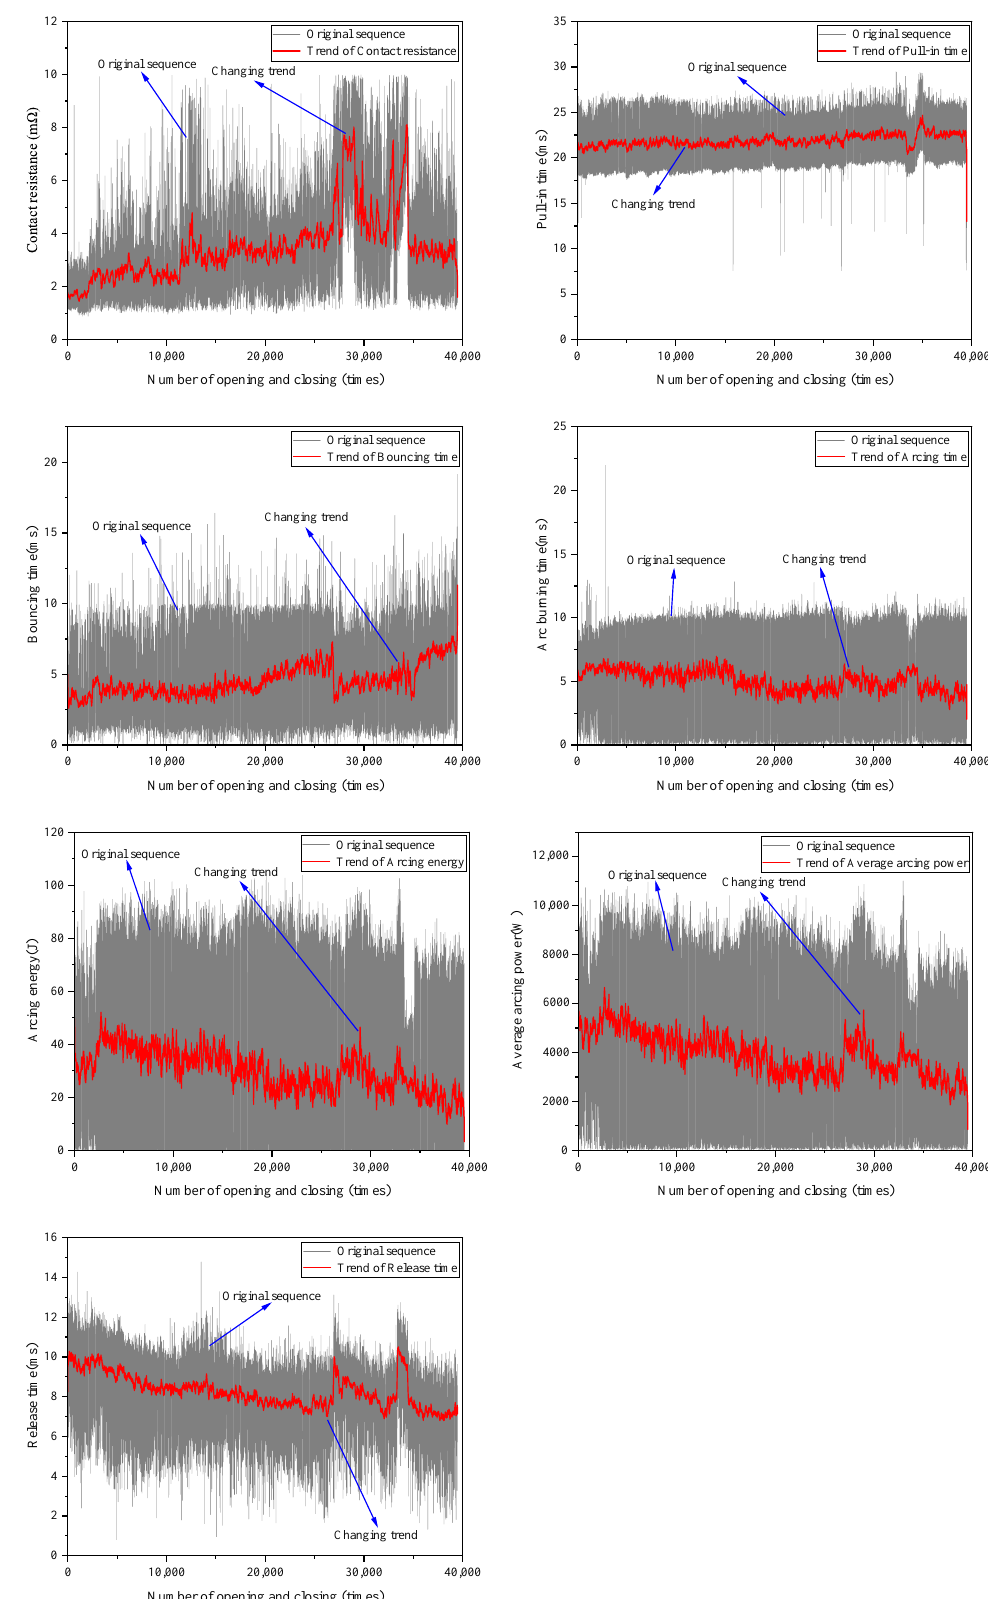
Figure 15. Diagram of feature trend